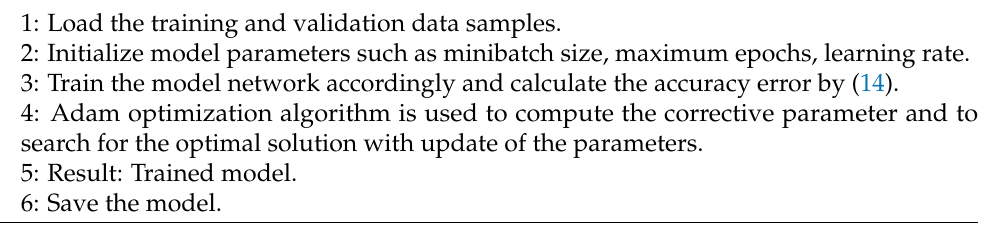
Algorithm 1 BiLTSM Training Process